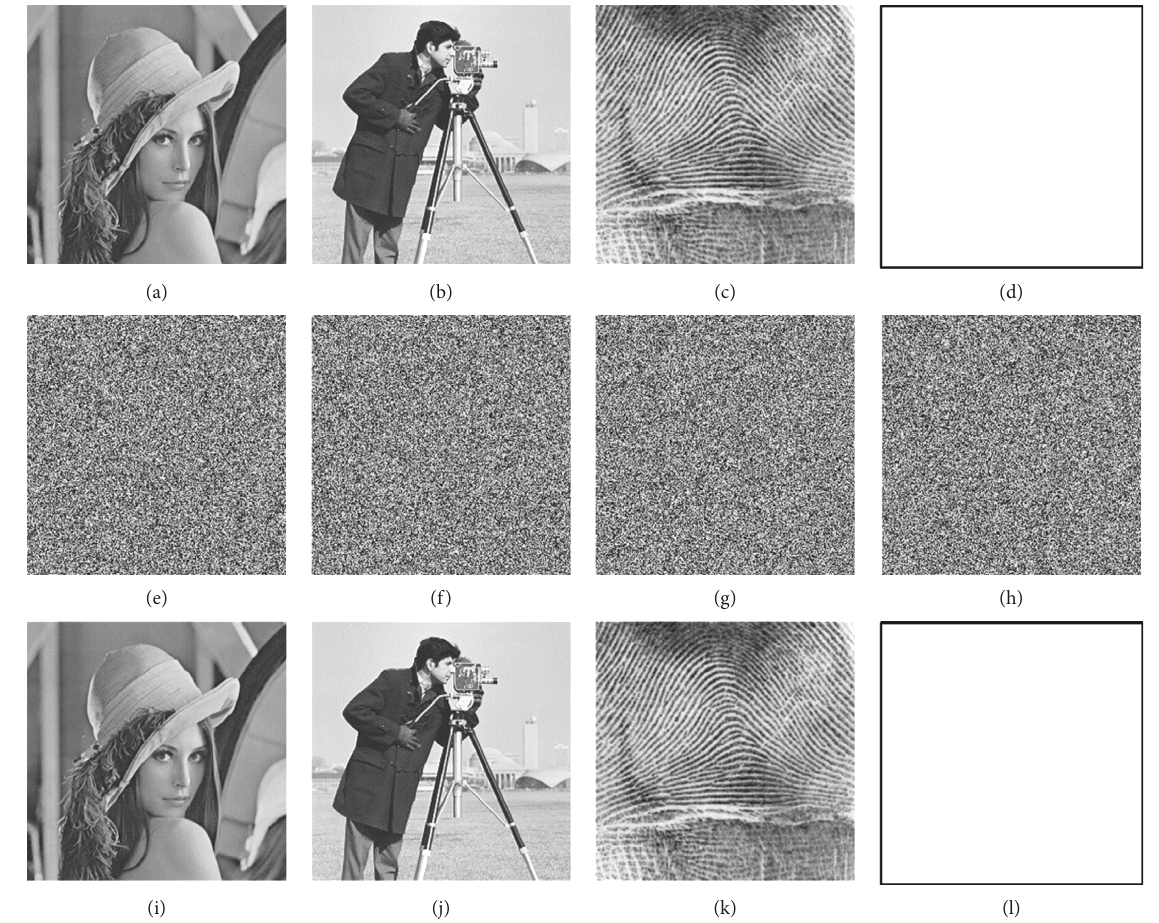
Figure 6: Original images, encrypted images, and decrypted images. (a) Lena. (b) Cameraman. (c) Fingerprint. (d) All white. (e) Encrypted Lena image. (f) Encrypted cameraman image. (g) Encrypted fingerprint image. (h) Encrypted all white image. (i) Decrypted Lena image.